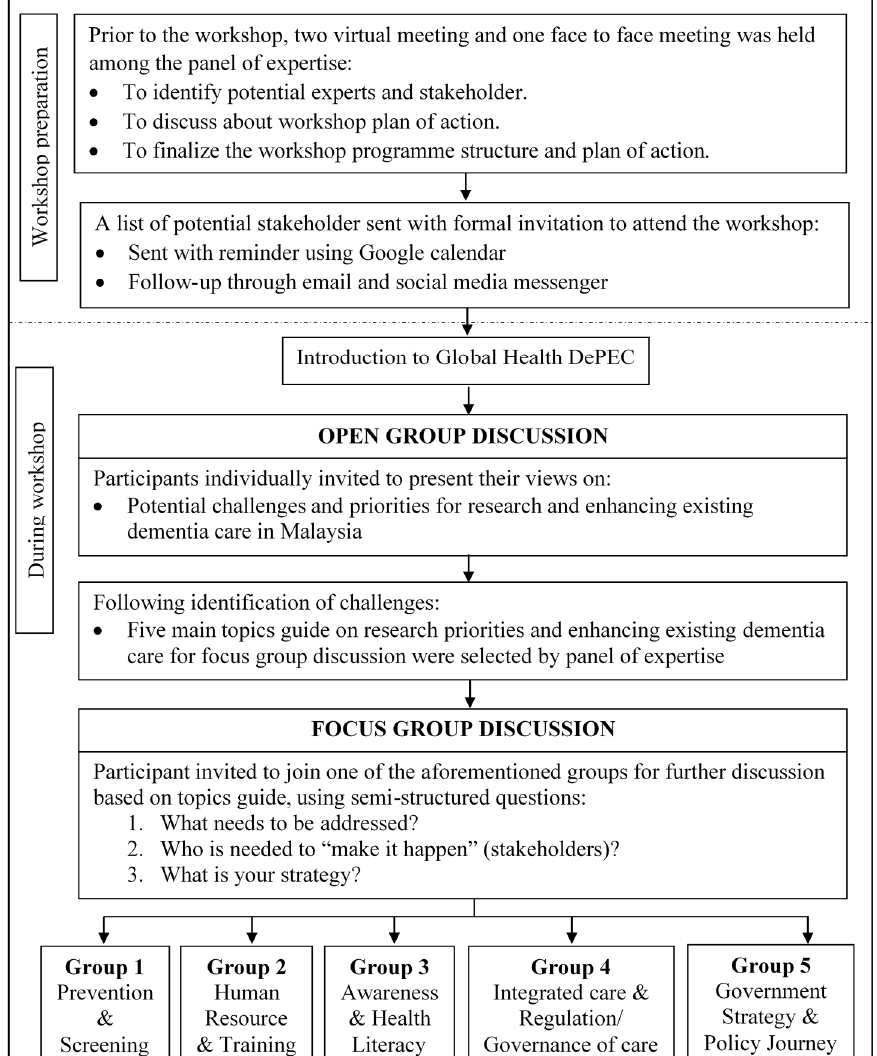
Figure 1. The flow of Malaysian DePEC Workshop. Note: DePEC = dementia prevention and enhanced care .